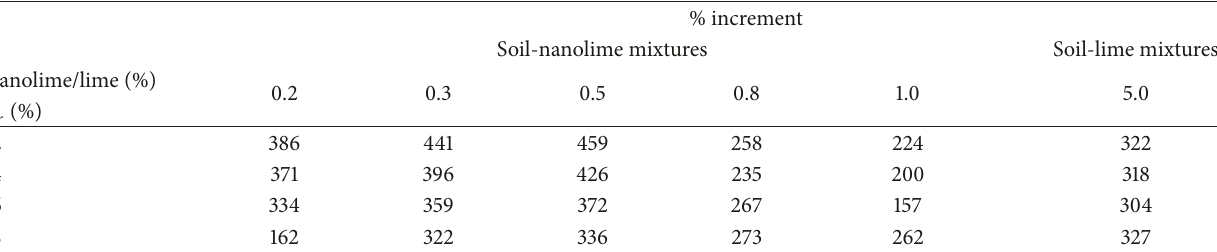
Figure 6: UCS development over curing periods for original soil, soil-nanolime mixtures, and soil-lime mixture at remolded water content of 18%. Table 4: Improvement of UCS for soil-nanolime mixtures after 56 days’ curing period.